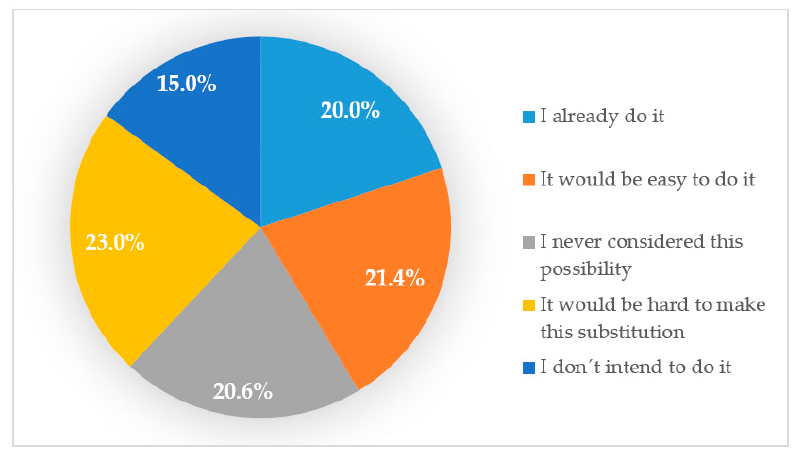
Figure 1. Readiness for replacement of animal products with pulses. Table 4. Willingness for the replacement of meat or fish by